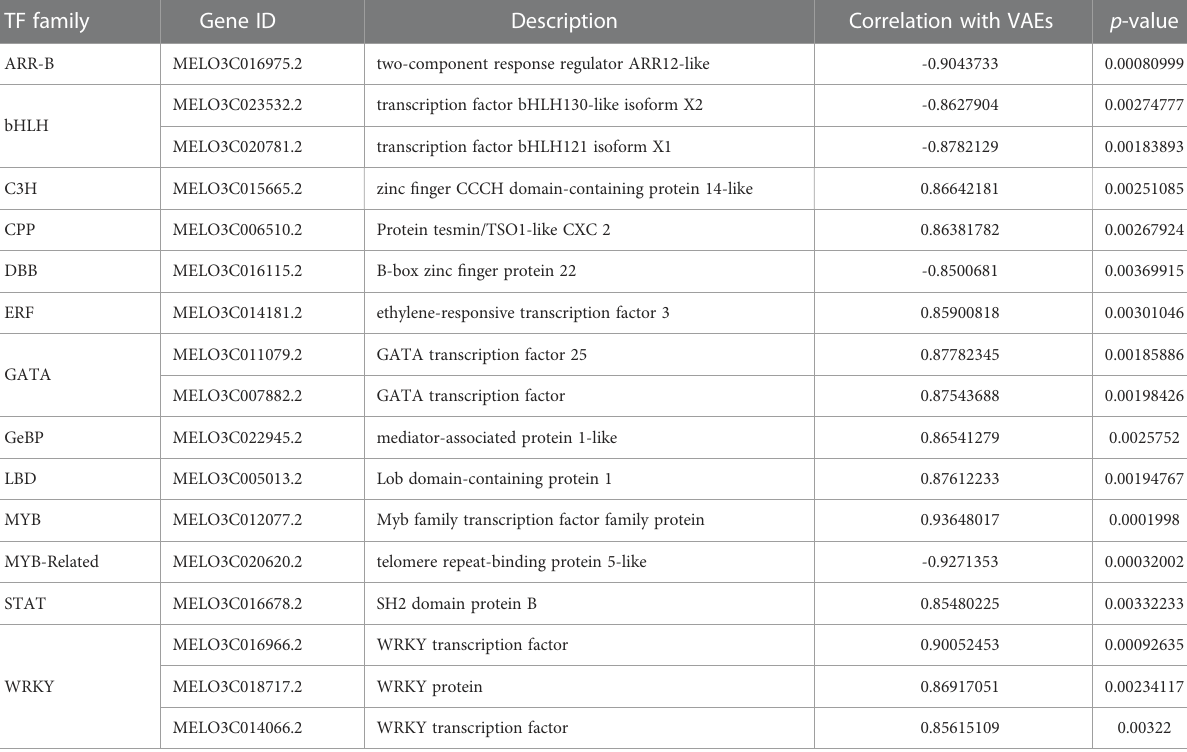
TABLE 1 The candidate transcription factors potentially involved in VAE